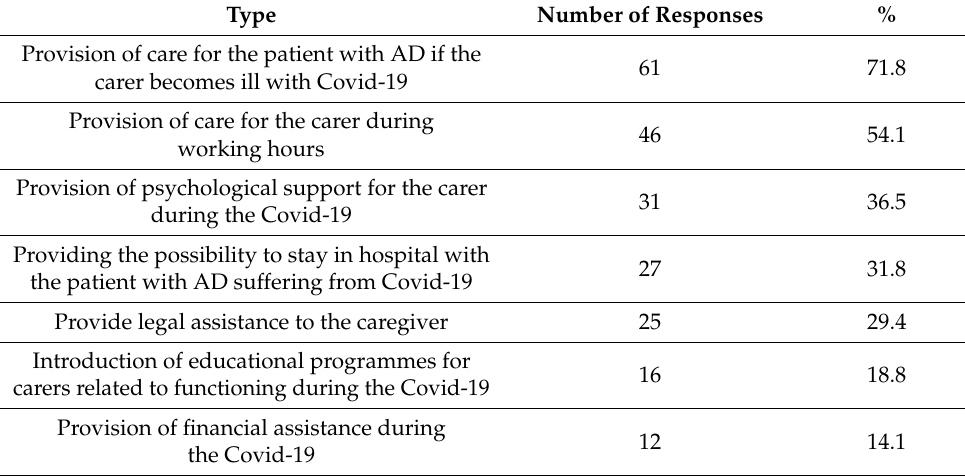
Table 3. Type of assistance expected by caregivers of charges with AD in relation to the Covid- 19